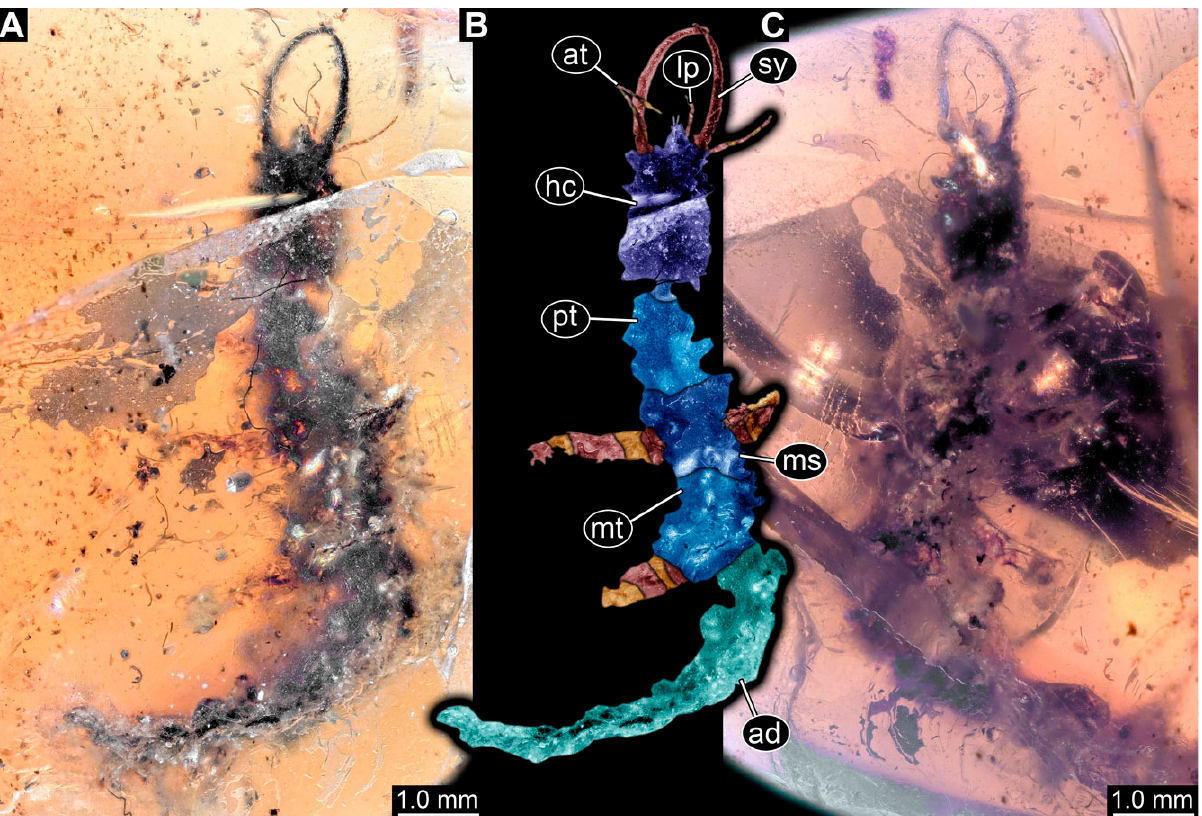
Figure 13. Specimen 73 (PED 0998); Myanmar amber. ( A ) Dorsal view. ( B ) Dorsal view, colour-marked. ( C ) Ventral view. Abbreviations: ad = abdomen; at = antenna; hc = head capsule; lp = labial palp; ms = mesothorax; mt = metathorax; pt = prothorax; sy = stylet. (22) Specimen 74 (PED 1049) is preserved in Cretaceous Myanmar amber. The dorsal and ventral sides are accessible, but are partly concealed by dirt and Verlumung. Only the head, neck, and parts of the prothorax are present (Figure 14A,B). The labrum is trident-like with a larger spine-like protrusion in the middle and two smaller spine-like protrusions next to the large spine. The specimen has an estimated length of 7.2–8.0 mm. (23) Specimen 75 (PED 1459) is preserved in Cretaceous Myanmar amber (Figure 12F–I). The dorsal (Figure 12H) and ventral (Figure 12F,G) sides are accessible. The labrum is triangular in the dorsal view (Figure 12I). The antennae bear prominent setae at the distal ends. The specimen has an approximate length of 2.0